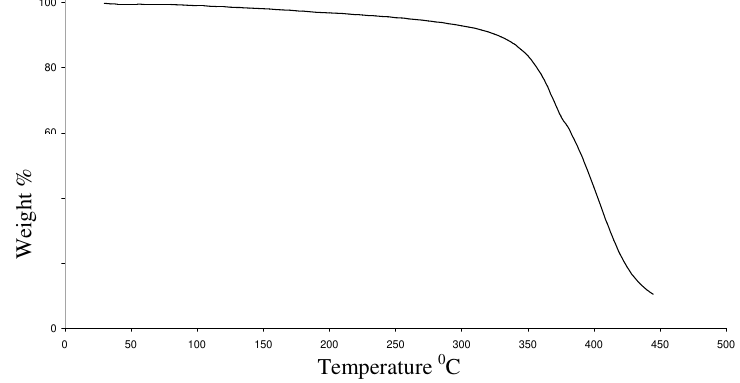
Figure 4. TG curve of epoxy acrylate with EOPA sample R